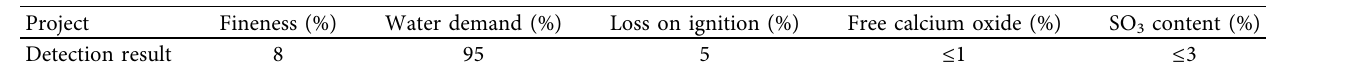
Table 4: Quality index of fly ash.